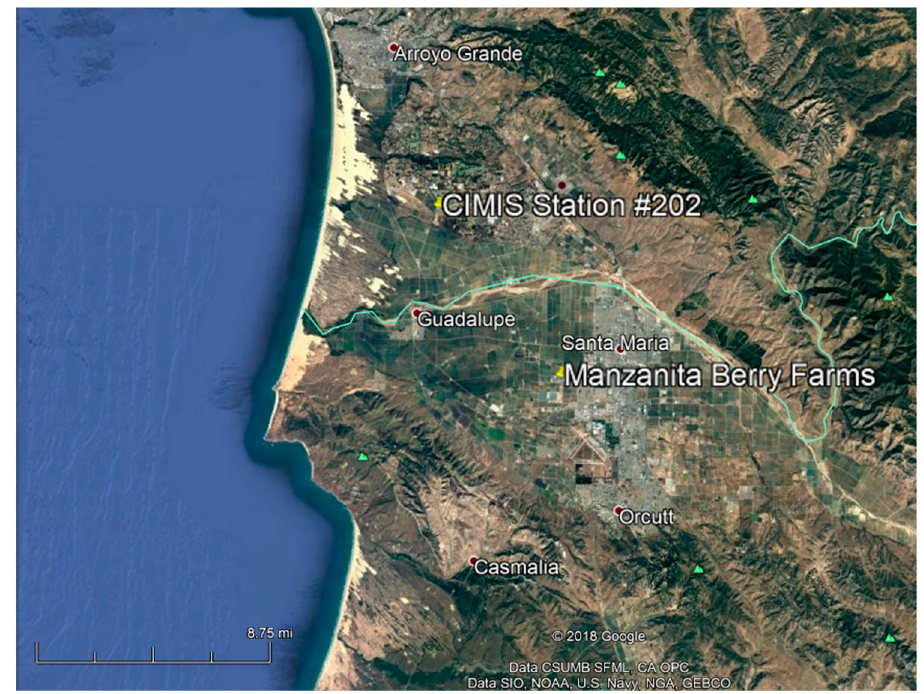
Figure 1. Location map of the study map together with the CIMIS (California Irigation Managament Information System) station 202 at